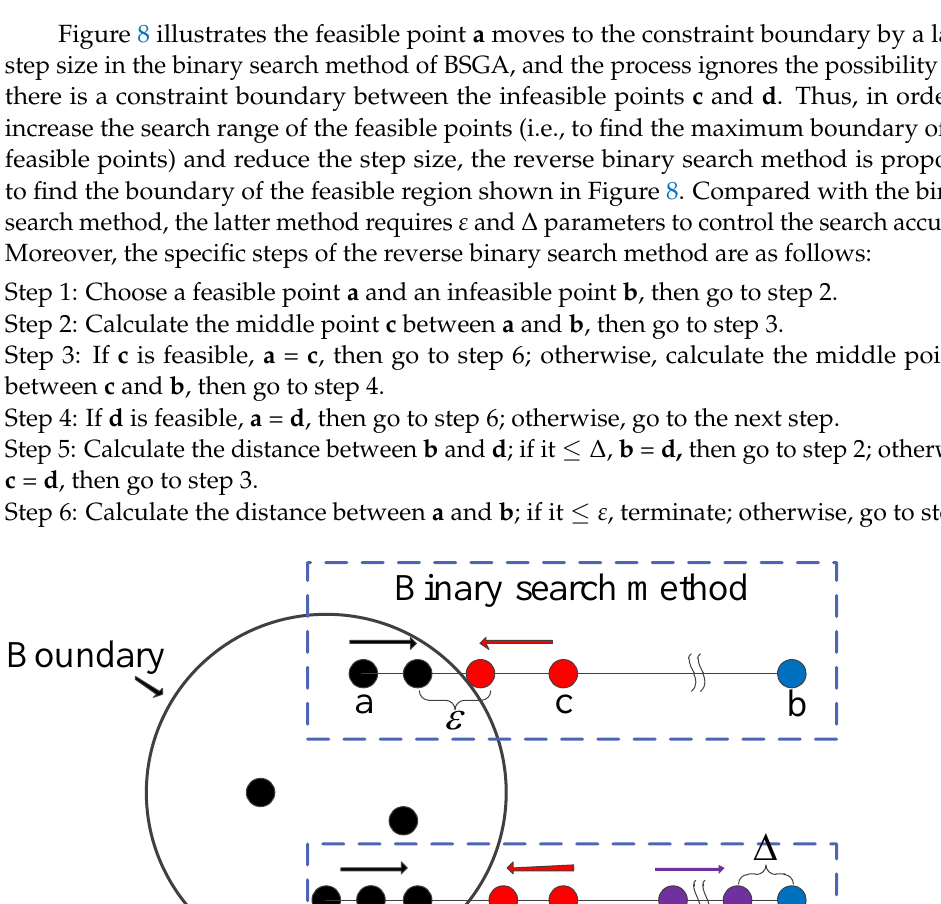
Figure 7. The distribution of point sets in the design domain.